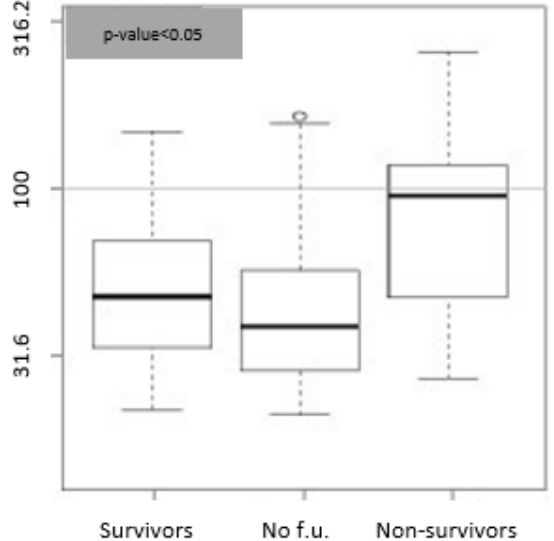
( c ) Figure 2. Bio-ADM concentrations expressed in pg/mL. ( a ) Box plot. Survivors: distribution of the Bio-ADM values of the patients who survived at 24 h ( n = 107, median = 26.7); no f.u.: distribution